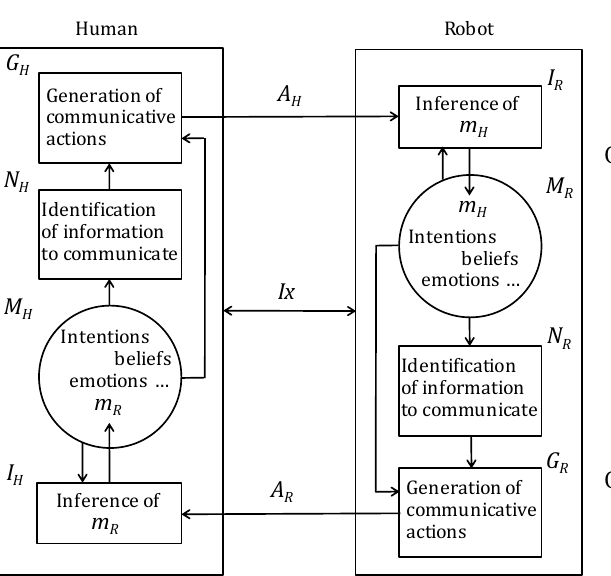
Figure 2: Model of how a human and robot infer an understanding of each other’s state-of-mind, through communicative actions A and A . m denotes the human’s model of the robot’s state-of- R R mind M , and m denotes the robot’s model of the human’s mind R H M H . Actions A R are generated based on the mismatch | m R − M R | between M and the robot’s estimation of m R and aim at reducing this mismatch. See text for further explanation.